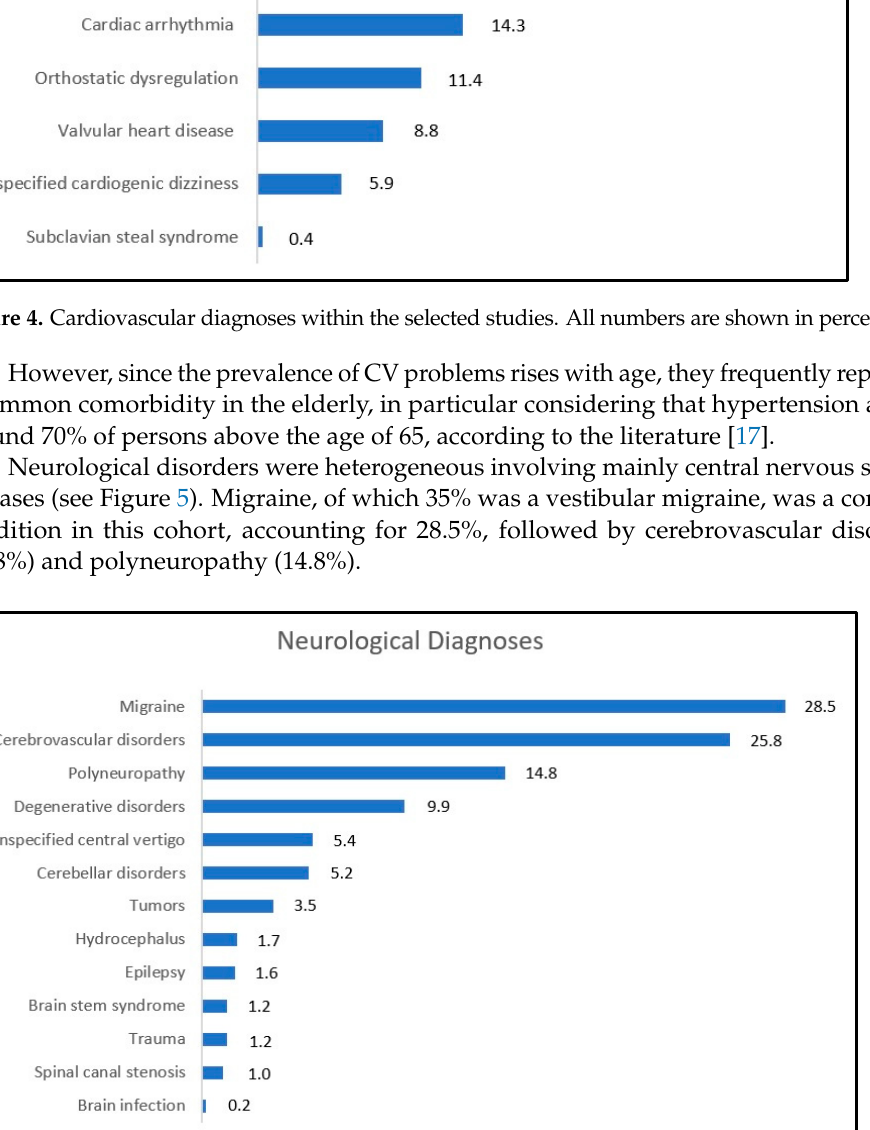
Figure 3. Audiovestibular diagnoses within the selected studies. All numbers are shown in percentages.